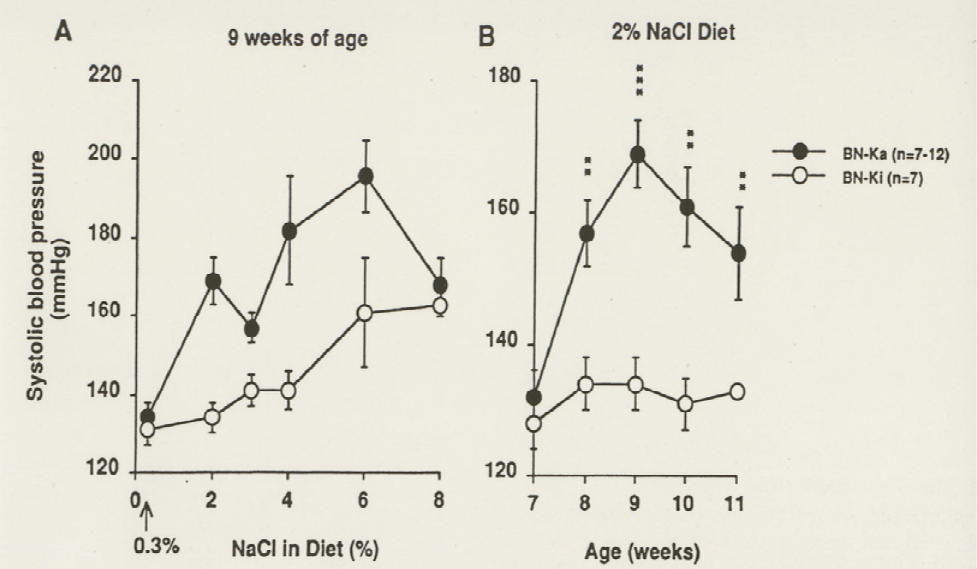
Figure 5. Changes in systolic blood pressure in normal Brown Norway-Kitasato (BN-Ki) rats and kininogen-deficient BN-Katholiek (BN-Ka) rats given NaCl-loaded diets. Both strains of rats were fed diet containing from 2% to 8% NaCl from the age of 7 weeks for two weeks (panel A) and a 2% NaCl diet between the ages of 7 to 11 weeks (Panel B). Values are means (±S.E.M.) of 7-12 rats. Values in BN-Ka rats were compared with those in BN-Ki rats of the same age. **P < 0.01, *** P < 0.001 (reproduced from Ref. [145] with